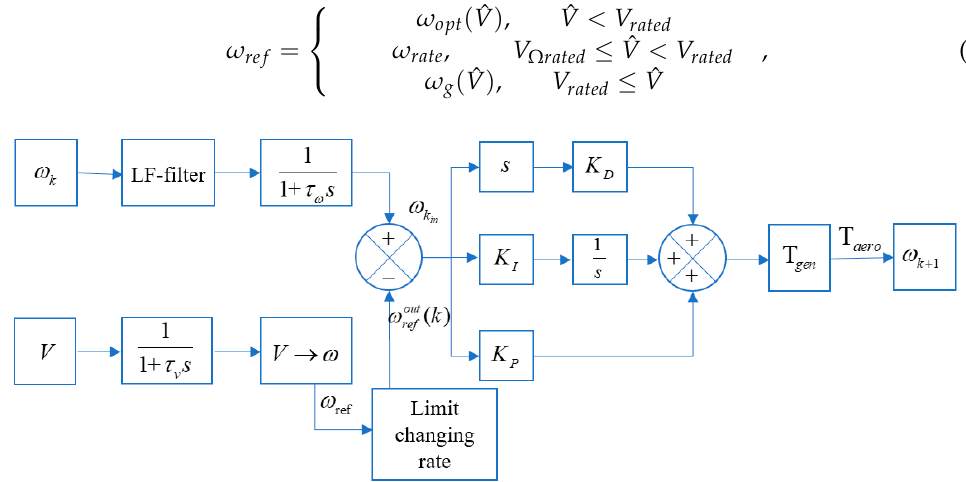
Figure 4. PID-based controller diagram of the helical VAWT.